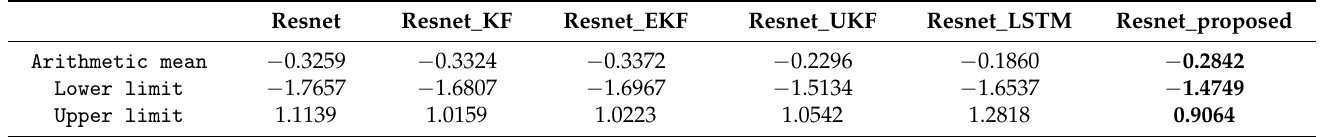
Table 2. Six groups of Bland–Altman plot